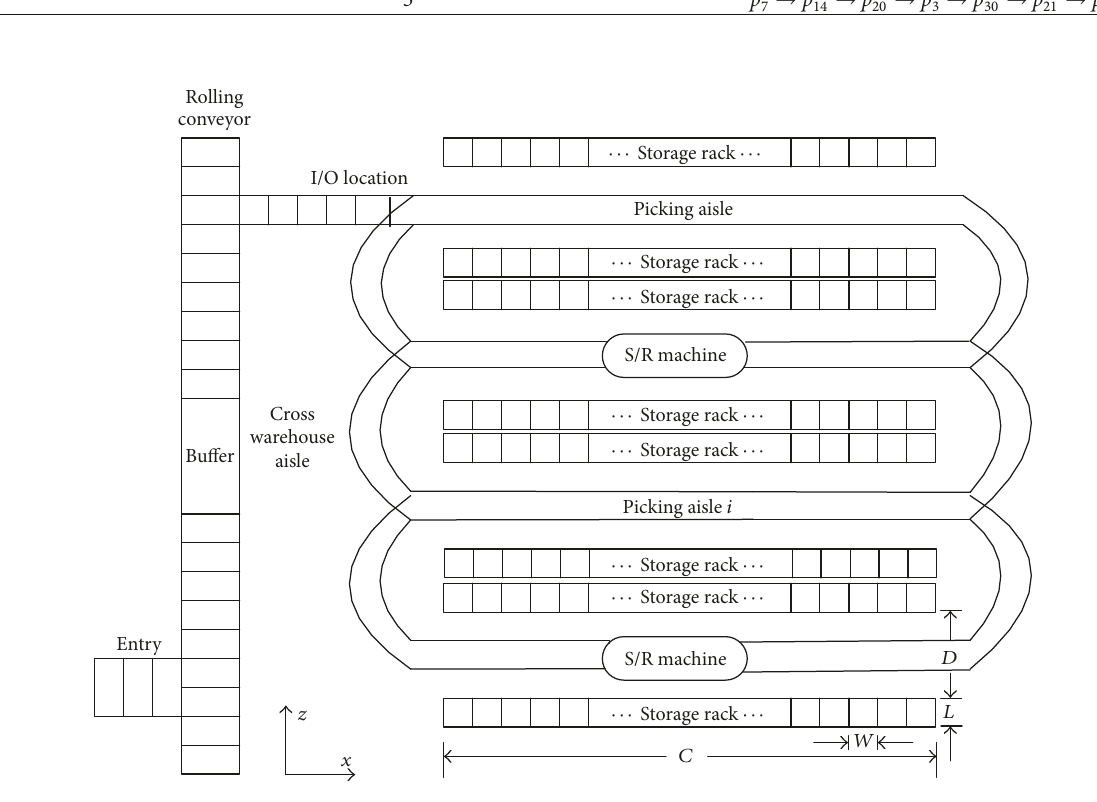
Figure 3: Layout of the warehouse